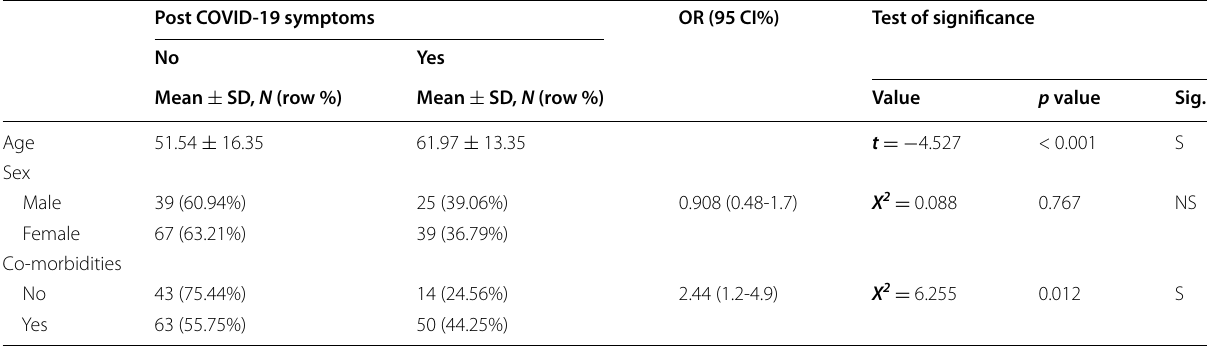
OR odd ratio, CI confidence interval, t student t test value, X 2 chi square test value, statistical significance at p